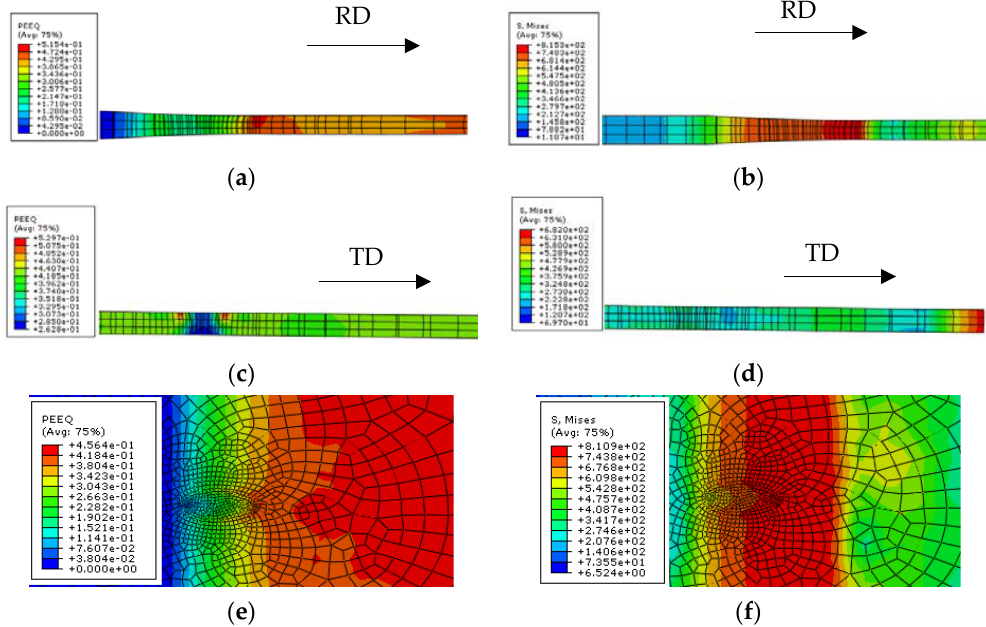
Figure 4. Stress-strain cloud diagrams of the rolling deformation zone for a strip with 0.25 mm grinding depth. Rolling direction (RD) ( a ) strain and ( b ) stress in cross section; transverse direction (TD) ( c ) strain and ( d ) stress in cross section; ( e ) stress and ( f ) strain cloud diagrams of the ground pit in the deformation zone.